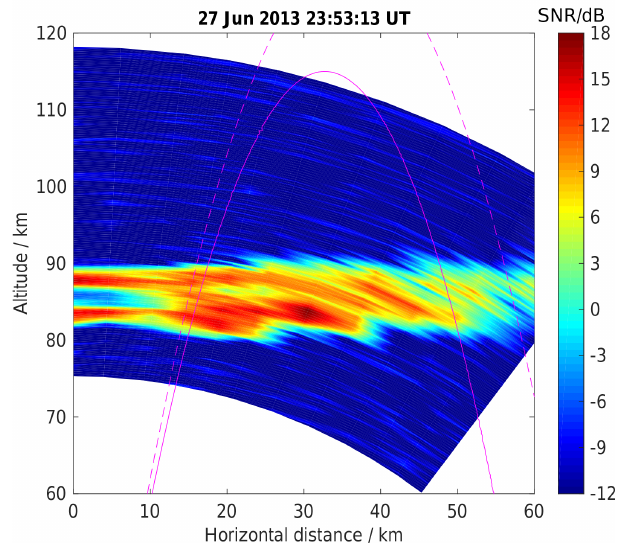
Figure 4. PMSE display observed by MAARSY along the rocket trajectory. Dashed and solid lines show predicted and actual trajec- tories,